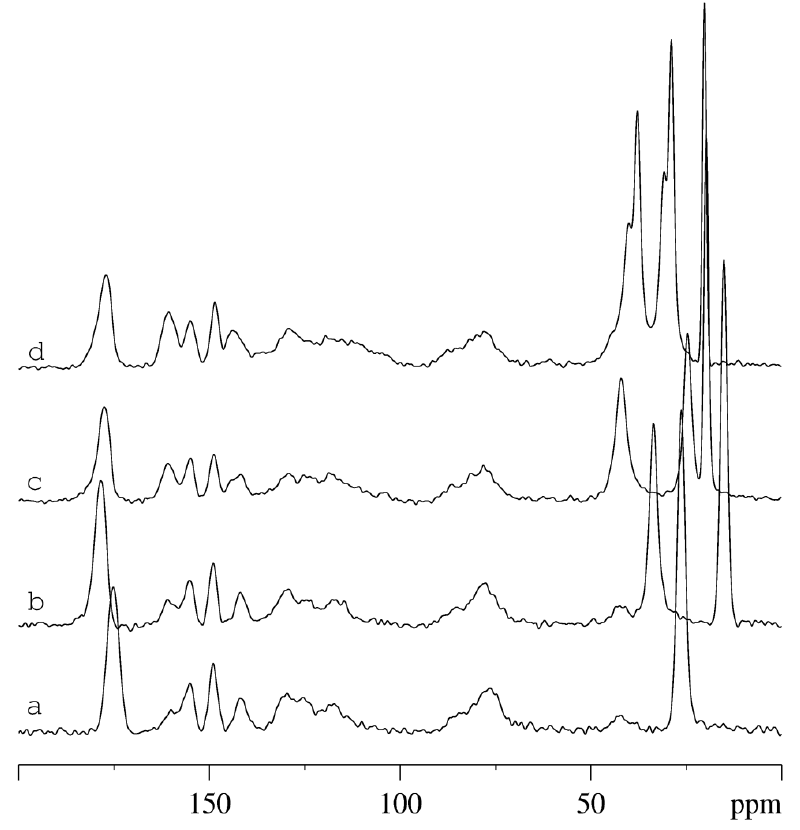
Figure 3. Comparison of solid state 13 C NMR spectra of isolated products from anhydride treatments with 10% 1-methylimidazole catalyst. ( a ) tannin acetate; ( b ) tannin propionate; ( c ) tannin butyrate and ( d ) tannin